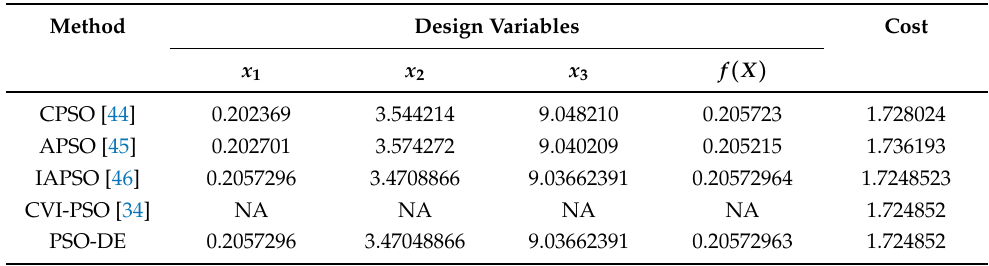
Table 13. Comparison of optimization results of different algorithms for the welding beam problem. NA indicates that it has not been addressed in the literature.